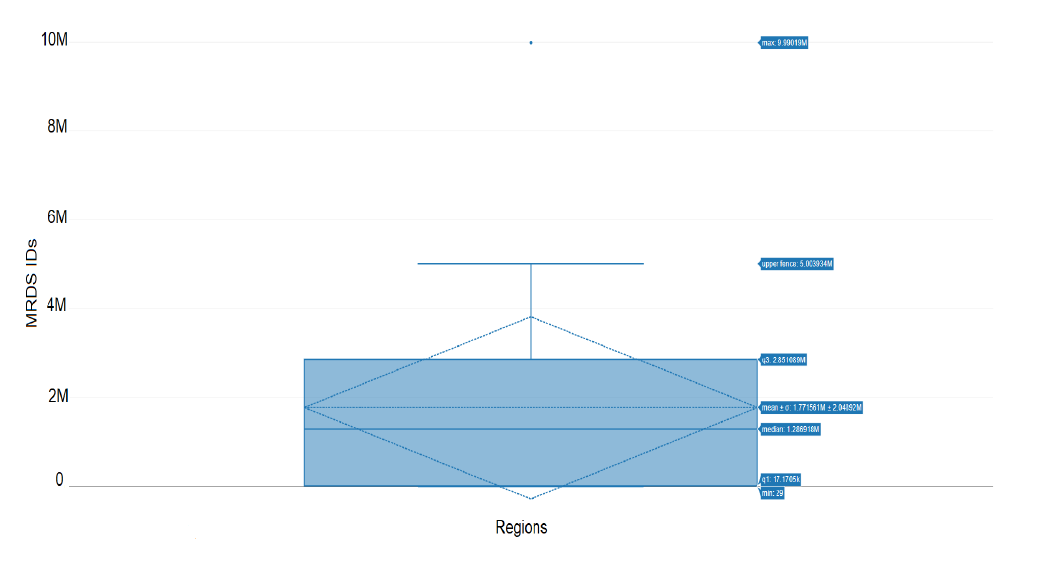
Figure 14. Mean and standard deviation plot between attributes “region” and